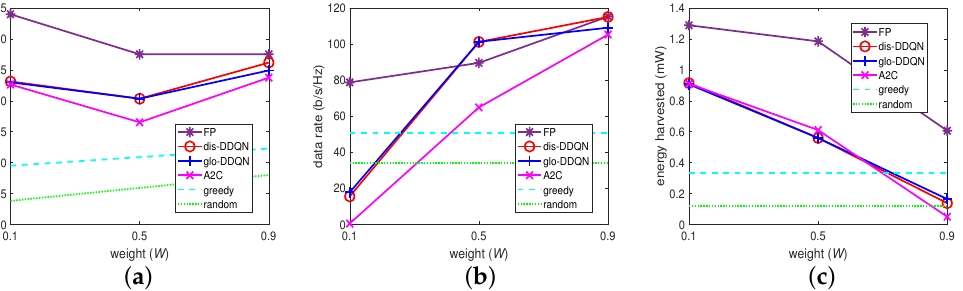
Figure 7. Comparison with different weights: ( a ) utility, ( b ) data rate, and ( c ) harvested energy. First, with respect to its variant (glo-DDQN), it can be observed that both algorithms (dis-DDQN and glo-DDQN) converge to similar results, and glo-DDQN can barely obtain